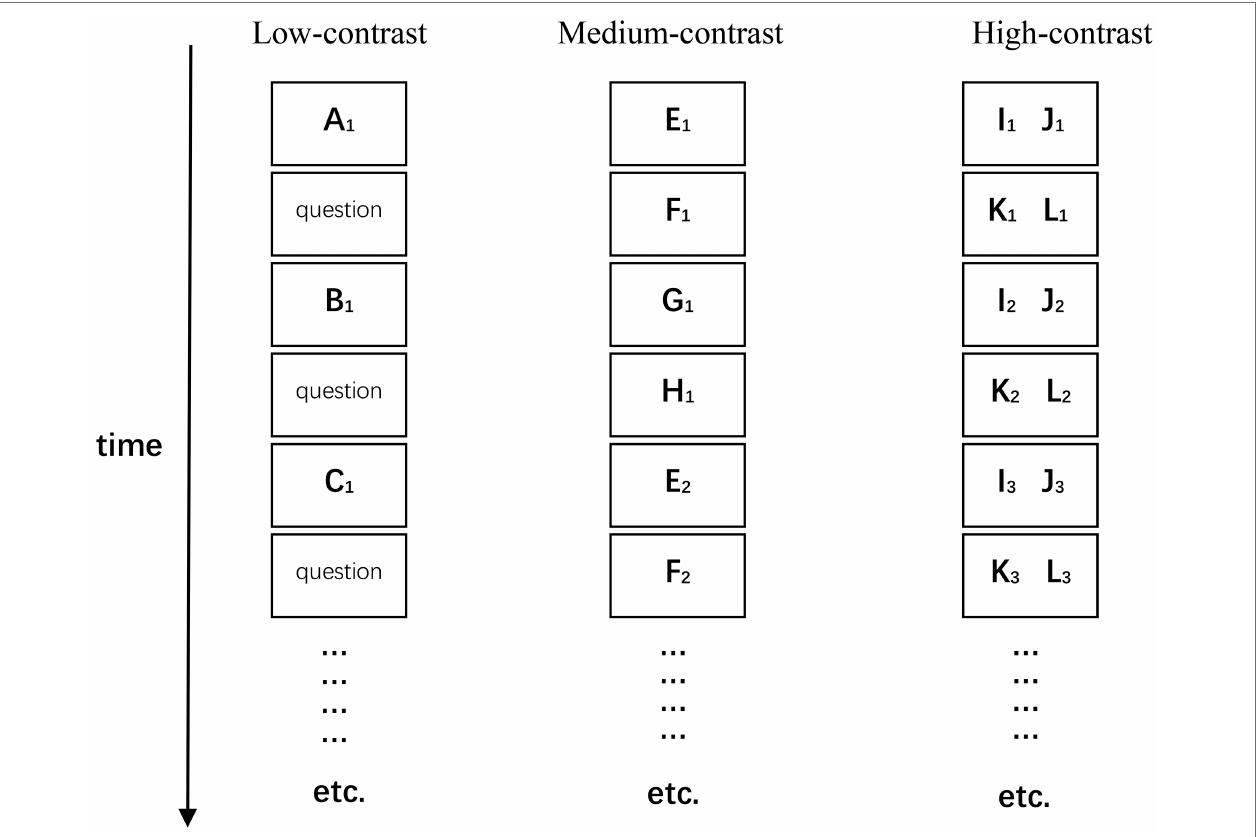
FIGURE 6 | The sequence of paintings during the study phase for the study conditions in Experiment 3. Letters denote a specific artist, and subscript numbers denote a particular painting by that artist.